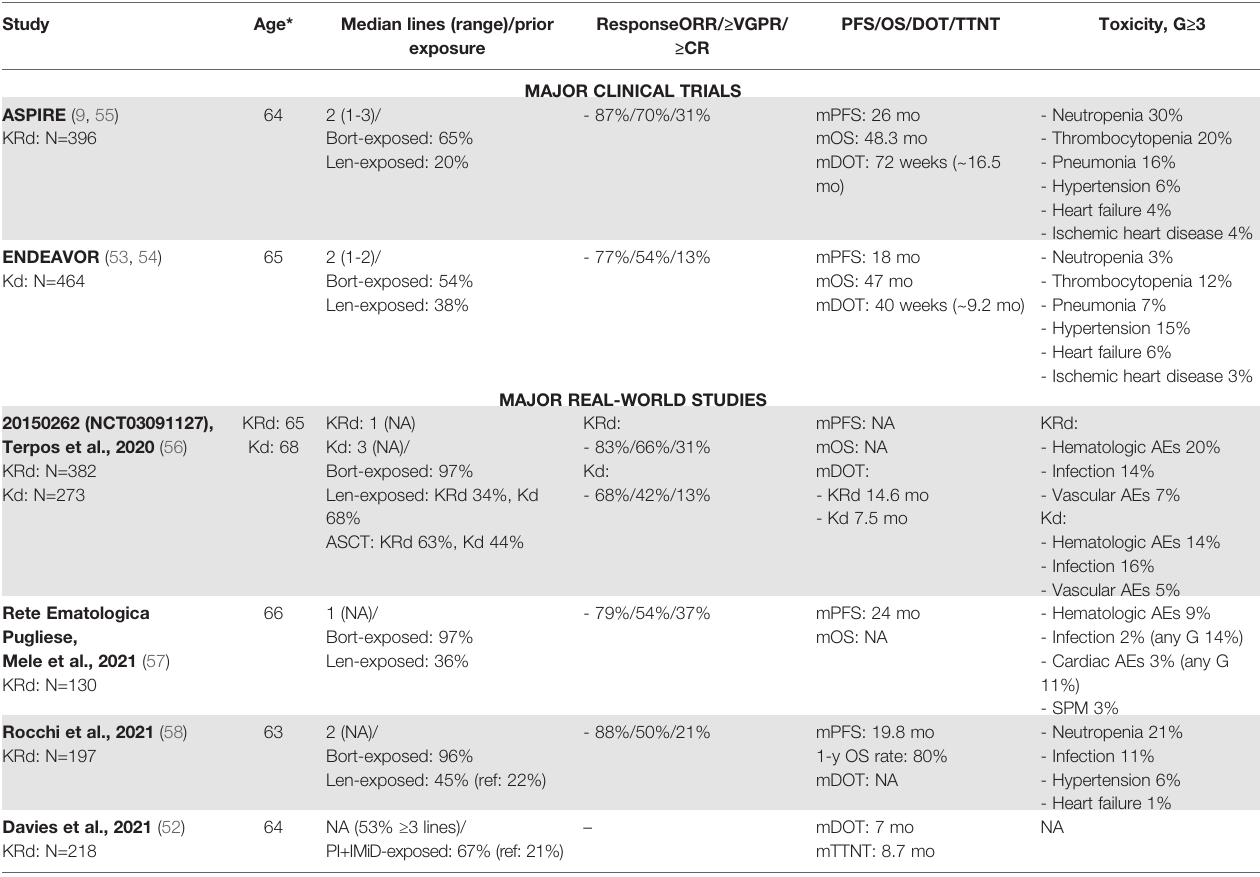
TABLE 3 | Major clinical trials and real-world studies based on car fi lzomib for the treatment of RRMM. Study Age* Median lines (range)/prior